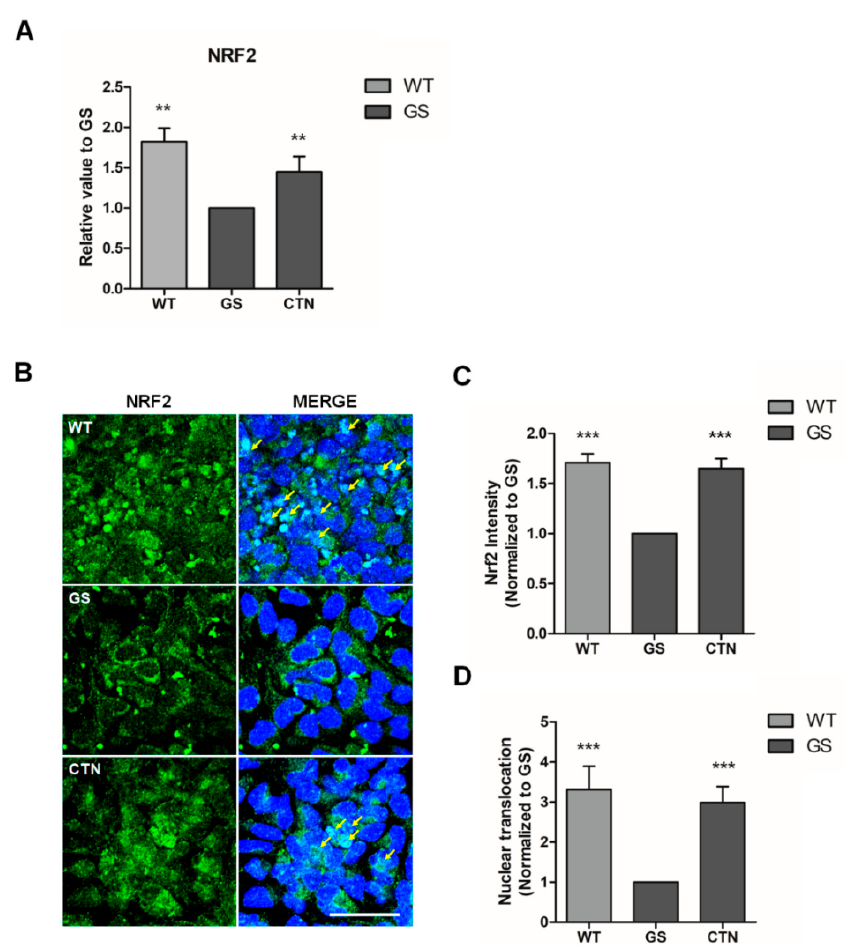
Figure 5. Expression and sub-cellular localization of nuclear factor erythroid 2-related factor 2 ( NRF2 ) in an in vitro PD model. ( A ) mRNA expression of NRF2 —the master regulator of antioxidant responses. ( B ) Immunofluorescence analysis of NRF2 labeled by Fluorescein (FITC, green). Cell nuclei were stained with Hoechst33342 (blue). Scale bar is 20 µ m. ( C ) Intensities of NRF2 expression. ( D ) Quantification of NRF2 nuclear translocation. Data are mean ± standard error of means (SEM) of at least three independent experiments. p -values were analyzed using the unpaired two-tailed Student’s t -test (* p < 0.05, ** p < 0.005, *** p < 0.001).